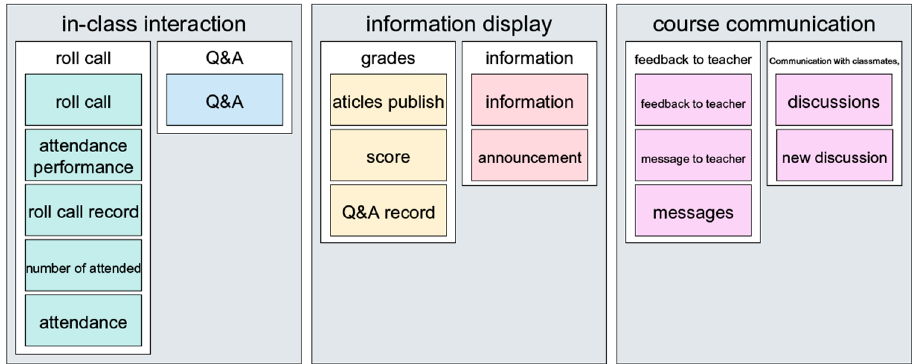
Figure 9. Subcategories included in the three categories.